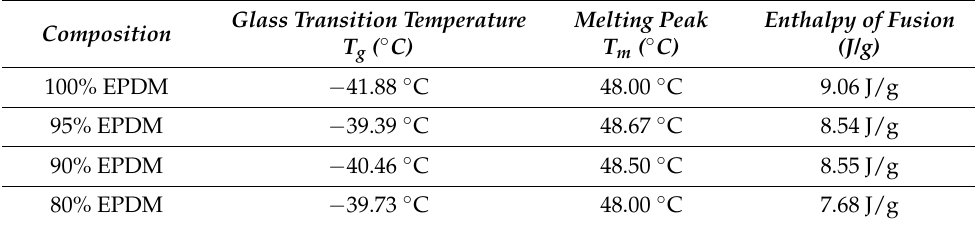
Table 2. Glass transition temperature (T g ), melting peak (T m ), and enthalpy of fusion for EPDM and GTR + EPDM composites.